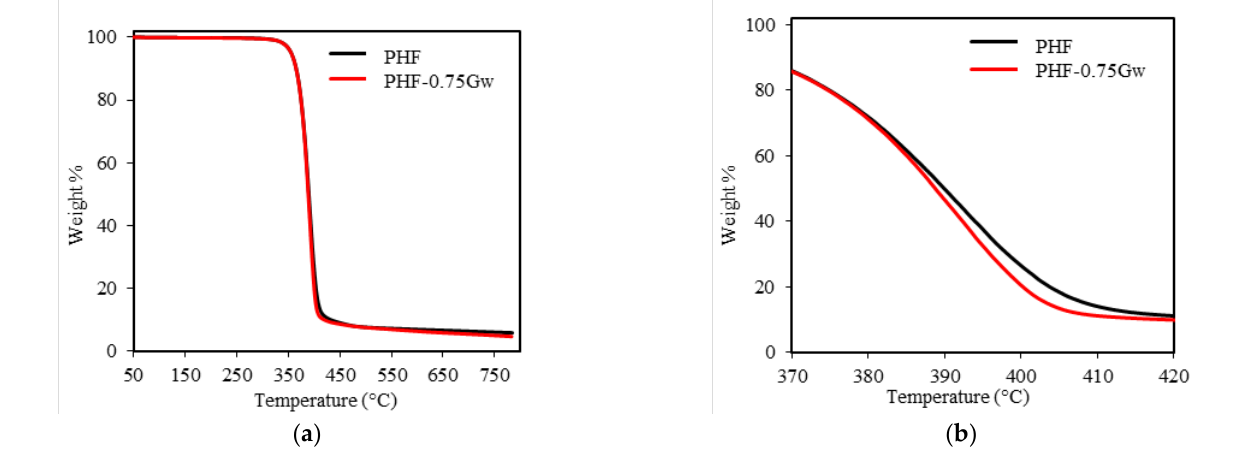
Figure 8. ( a ) Thermogravimetric curves of PHF samples; ( b ) zoomed region. Temperature and frequency dependent mechanical relaxation data for amorphous Table 2. Thermal relevant data of PPF and PHF homopolymers and nanocomposites T onset